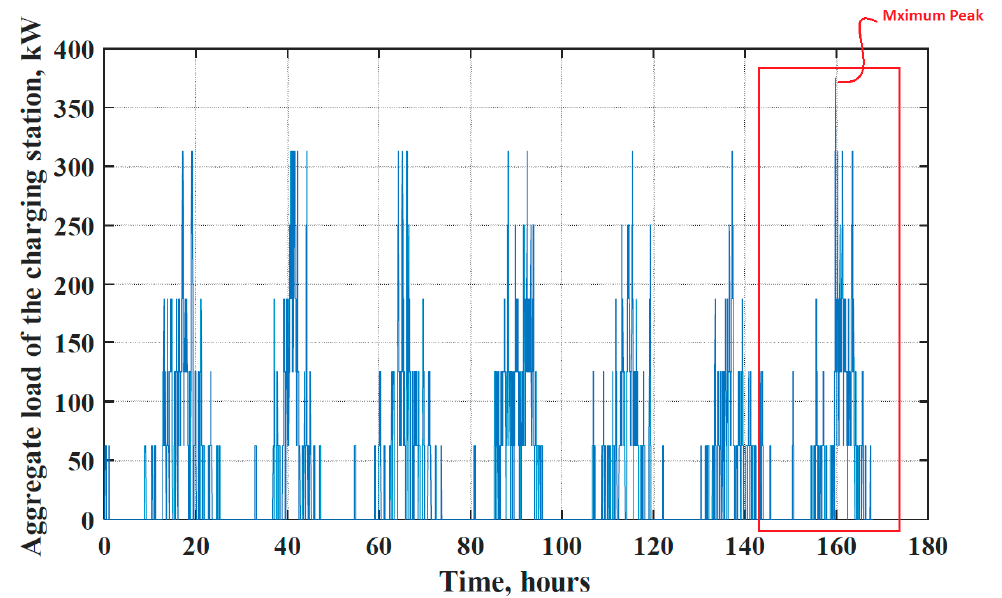
Figure 13. Demand MW/Time model of an XFC station during a week for a ~500 kW station.